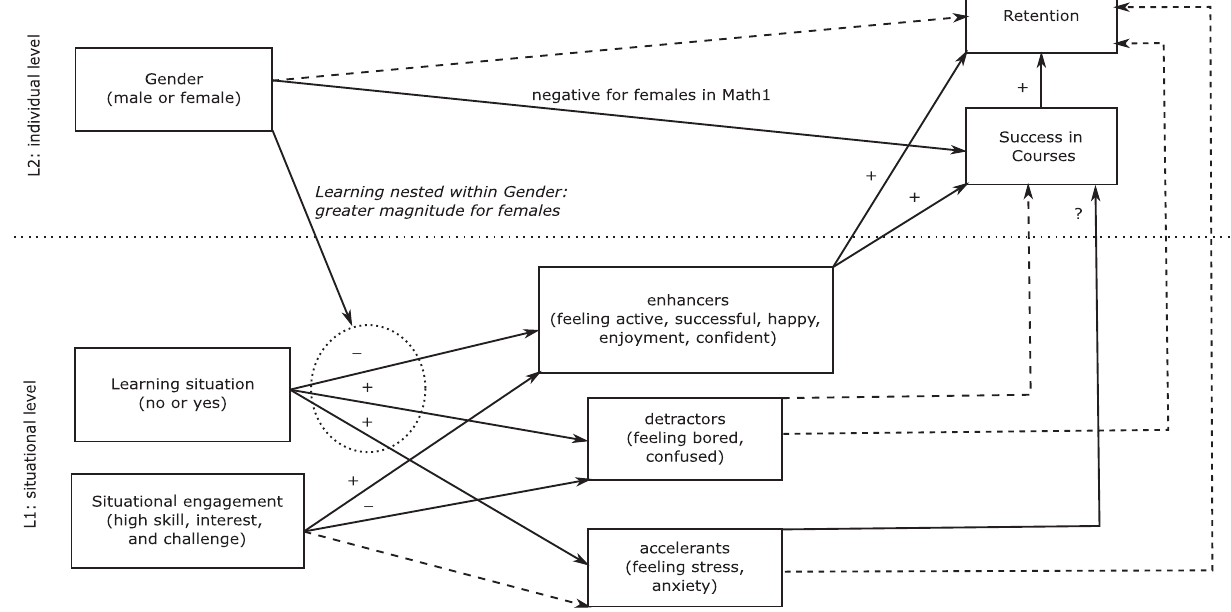
FIG. 3. Summary of results. Data supported connections are marked with solid arrows and unsupported hypotheses with dashed arrows. Plus sign ( þ ) indicates a positive connection, minus sign ( − ) a negative one. Question mark (?) indicates a more complicated